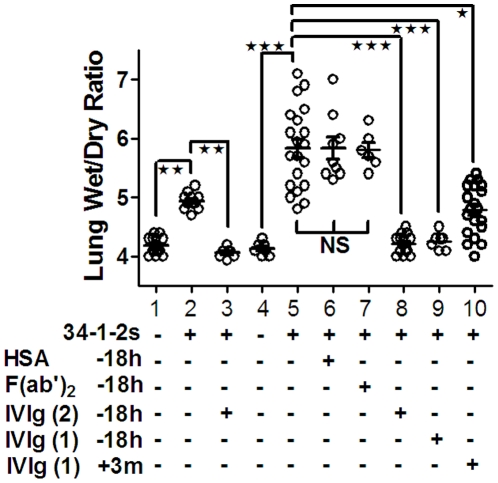
IVIg prevents 34-1-2s-induced lung damage in BALB/c and SCID mice.Wet/Dry ratios in non-treated (−) naïve BALB/c mice (column 1) and treated (+) BALB/c mice (columns 2,3) or SCID mice (columns 4–10) administered the indicated treatments (below left). TRALI was induced with an iv injection of 2 mg/kg 34-1-2s iv for SCID mice and 9 mg/kg 34-1-2s for BALB/c mice. Some mice were treated prophylactically 18 hours before TRALI induction with either 2 g/kg of IVIg (IVIg (2) −18 h), 1 g/kg of IVIg (IVIg (1) −18 h) or a control infusion with 2 g/kg human serum albumin (HSA −18 h) or 1 g/kg IVIg F(ab′)2 fragments (F(ab′)2 −18 h). The other mice were treated within 3 minutes after TRALI induction with 1 g/kg of IVIg (IVIg (1) +3 m). Two hours after TRALI induction, the mice were sacrificed and lung wet/dry (W/D) ratios were measured. The data is expressed as the individual mouse W/D ratios in each group and means±SEM are also shown. Statistics were performed using a one way ANOVA and the ★ indicates significance (p<0.001) between the indicated comparisons.